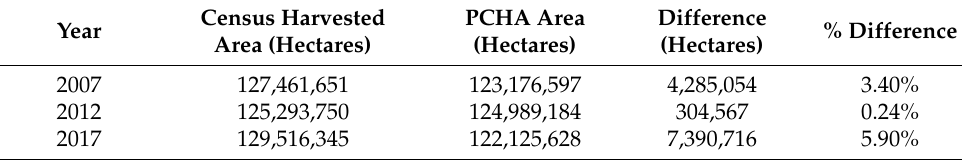
Table 1. Totals for Census harvested area and PCHA